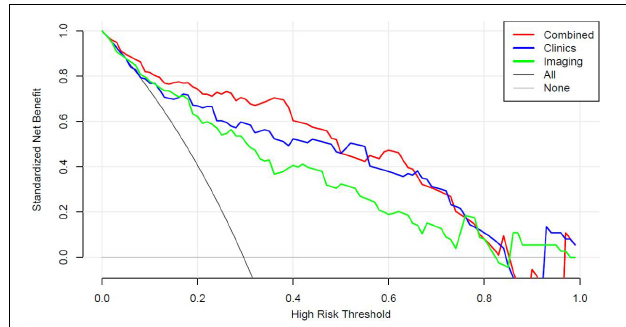
FIGURE 6 | Decision curve analysis (DCA) for the Nomogram model in validation cohort. Compared to other models, the combined Nomogram model, showing the highest area under the curve, is the optimal decision making for maximal net benefit in prediction of severe adenoviral